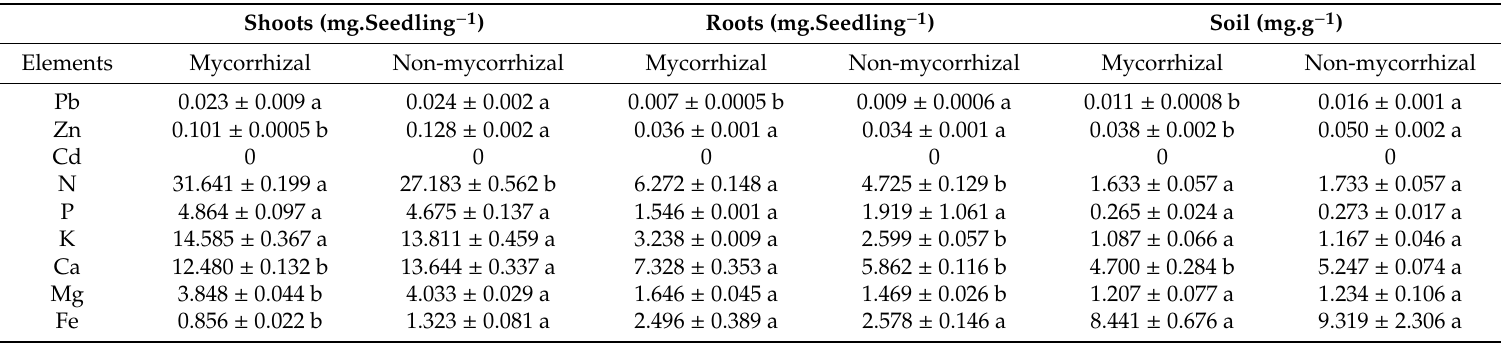
Table 2. Initial characterization of P. halepensis seedlings (shoots and roots) and their initial growth soil in the presence and absence of ectomycorrhizal fungi.